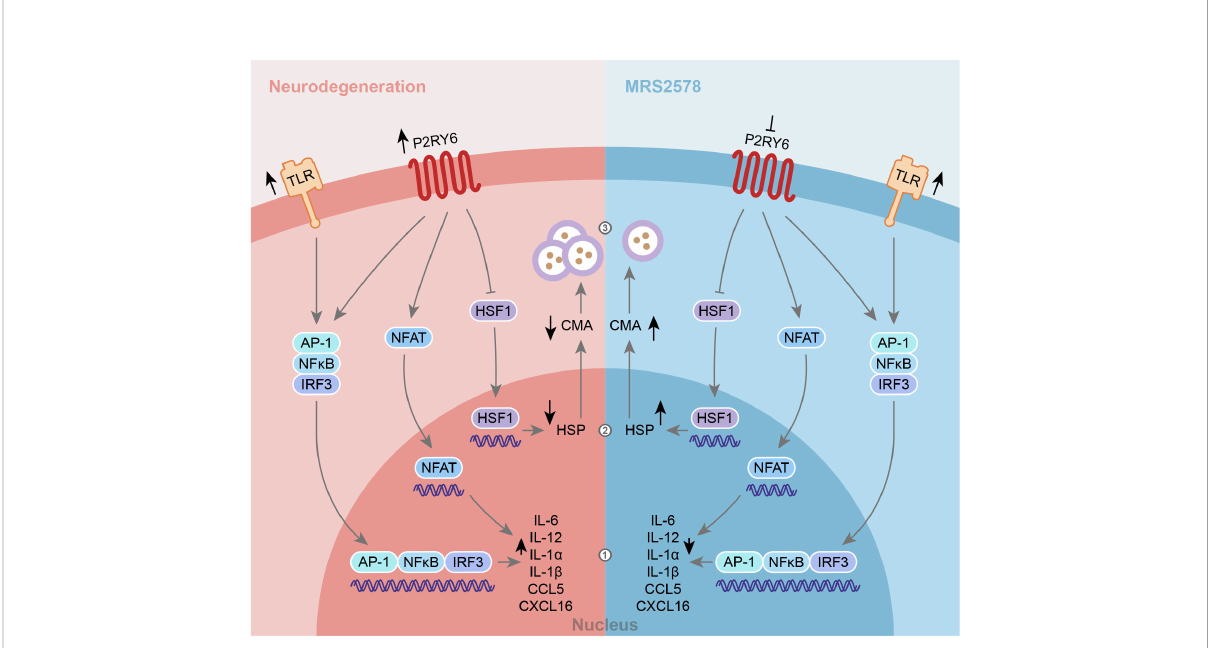
FIGURE 5 Schematic model of the contribution of P2RY6-mediated signaling during neuroin fl ammation. During neurodegeneration, TLRs and P2RY6 are described to be upregulated (16, 47, 48). The upregulation of both TLRs and P2RY6 may contribute to 1) chronic neuroin fl ammation, 2) downregulation of HSP, and 3) autophagosome accumulation due to impaired chaperone-mediated autophagy (CMA) processes, which are all hallmarks of neurodegenerative diseases. Our data show that blocking of P2RY6 with P2RY6 antagonist MRS2578 can 1) reduce the expression of pro-in fl ammatory cytokines and chemokines and 2) induce the expression of HSPs, which 3) may lead to increased CMA